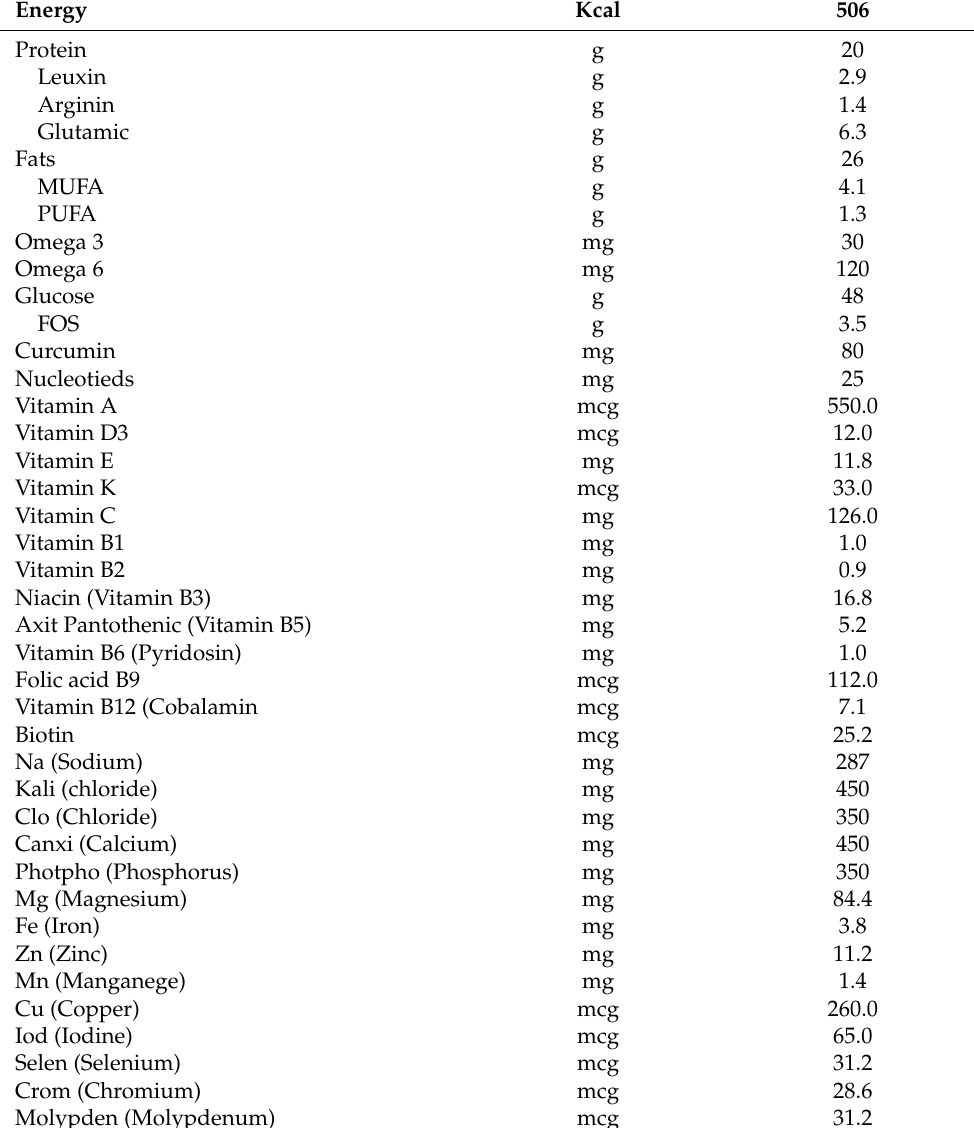
Table A1. Composition of nutrients in